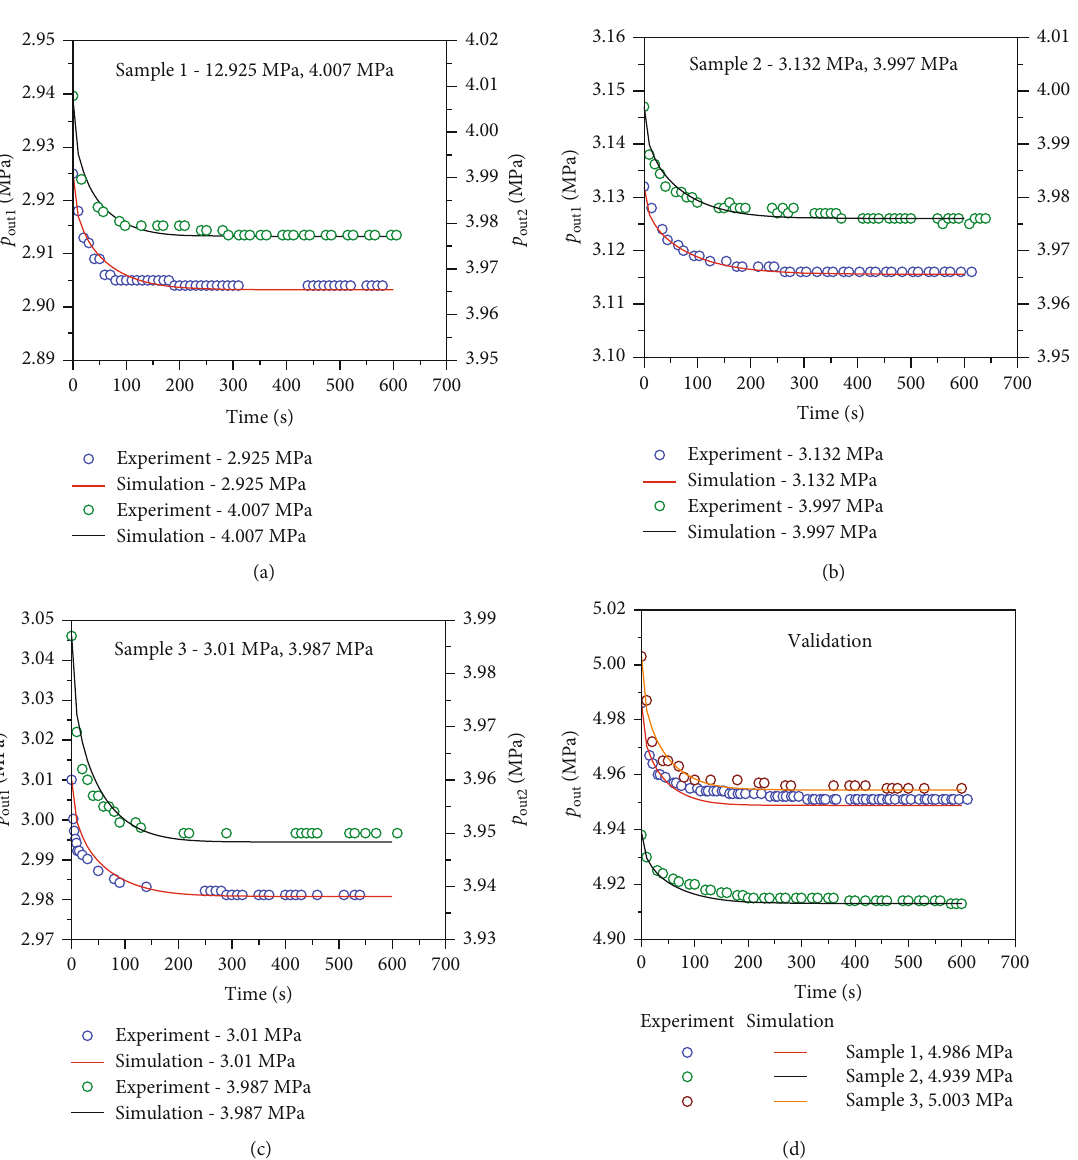
Figure 5: Curve fi tting with numerical method at 3 and 4MPa for Samples (a) 1, (b) 2, and (c) 3 and (d) validation of three samples at 5 MPa. The temperature is 303.15K. Table 3: Regressed parameters for Wufeng-Longmaxi samples.